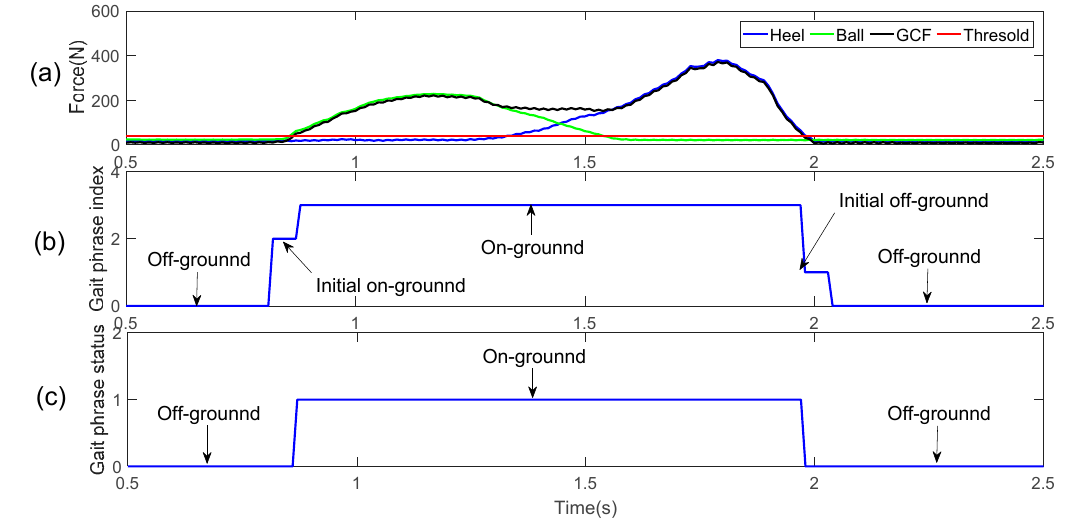
Figure 6. ( a ) Original gait GCF data, ( b ) four gait phase index, ( c ) two gait classification.